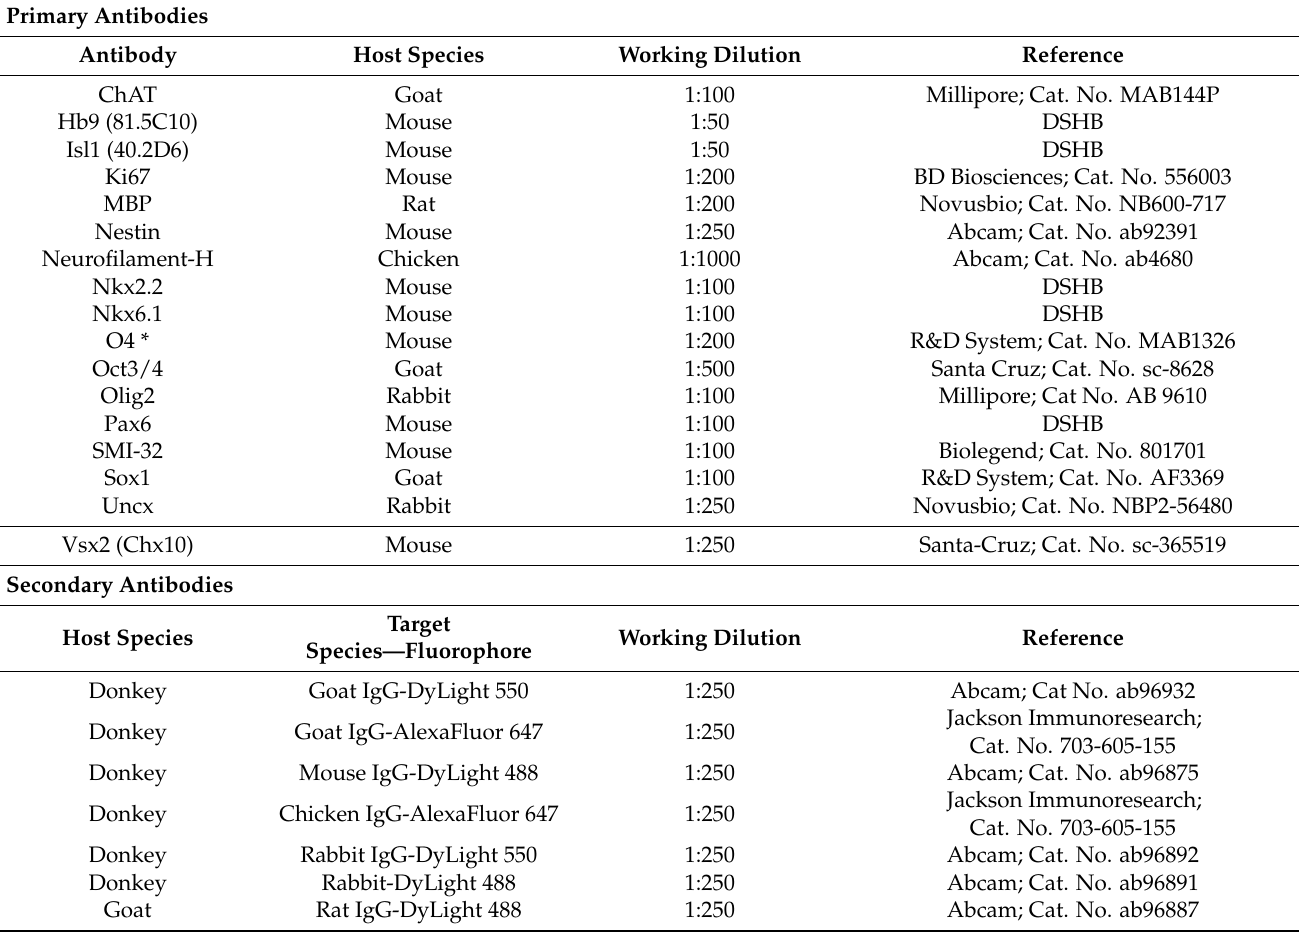
Table 8. Primary and secondary antibodies